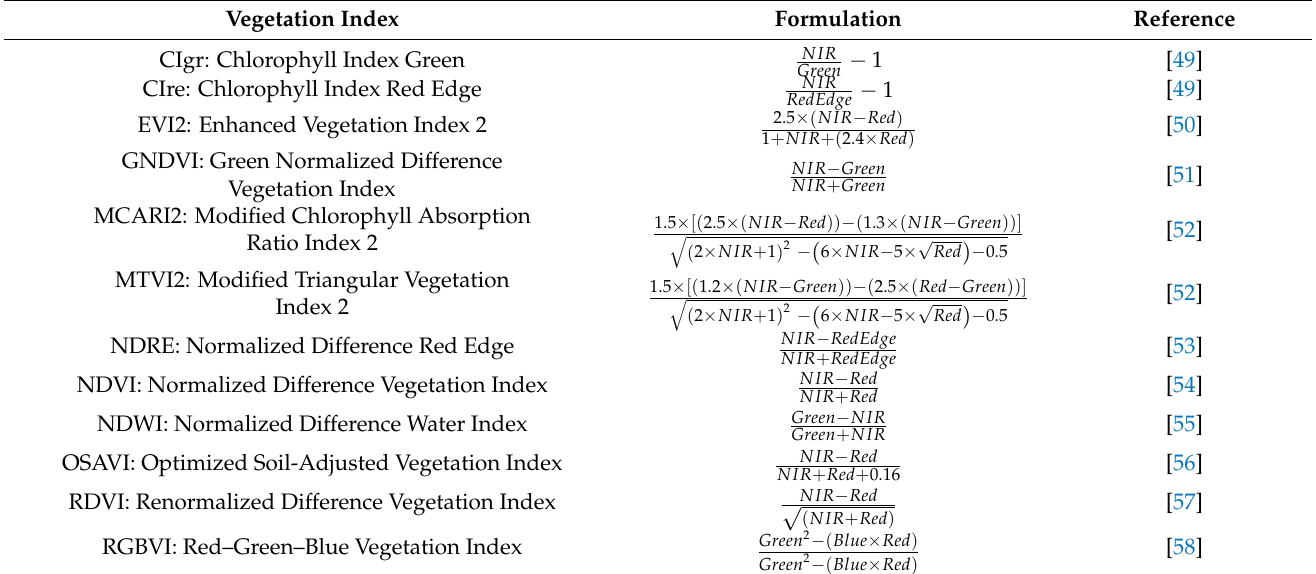
Table 2. Summary of vegetation indices that were extracted in the study. Vegetation Index